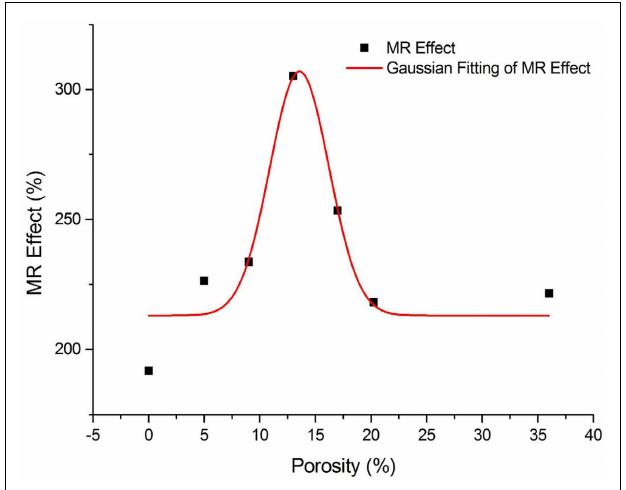
FIGURE 7 | MR effect of MRE samples with different porosities .